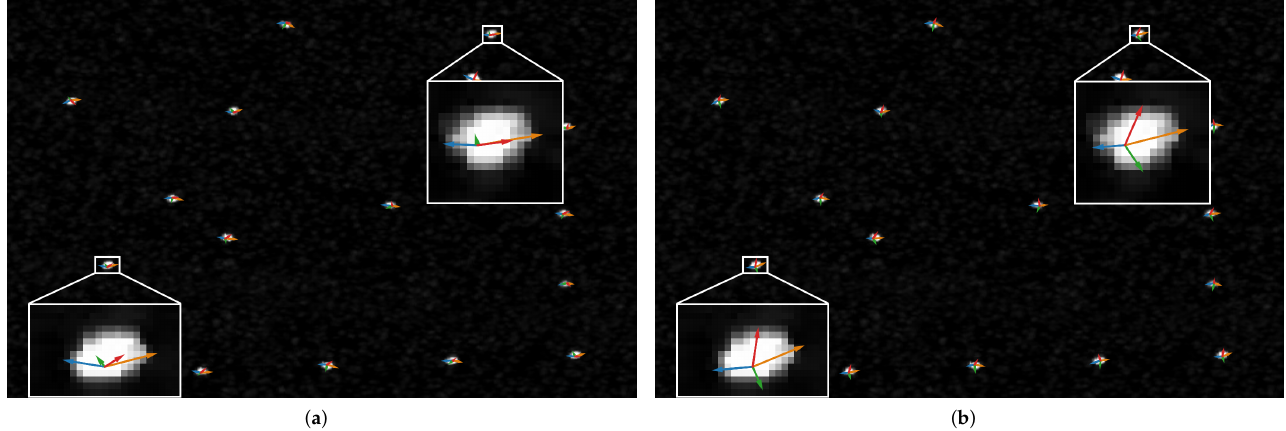
Figure 9. Visual comparison of shape descriptors trained by ( a ) fixed and ( b ) soft edge point assignment strategies, respectively. The blue, orange, green, and red arrows represent the u a , u b , v a , and v b pointers, respectively. Two shape descriptors are shown enlarged in white boxes for